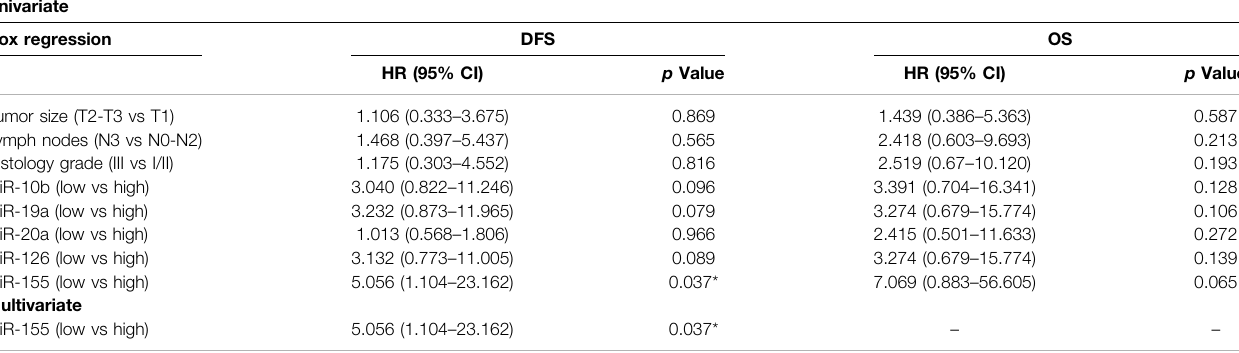
TABLE 4 | Univariate and multivariate analysis for DFS and OS in triple negative subgroup (TNBC) of patients with early breast cancer ( n (cid:1) 31).